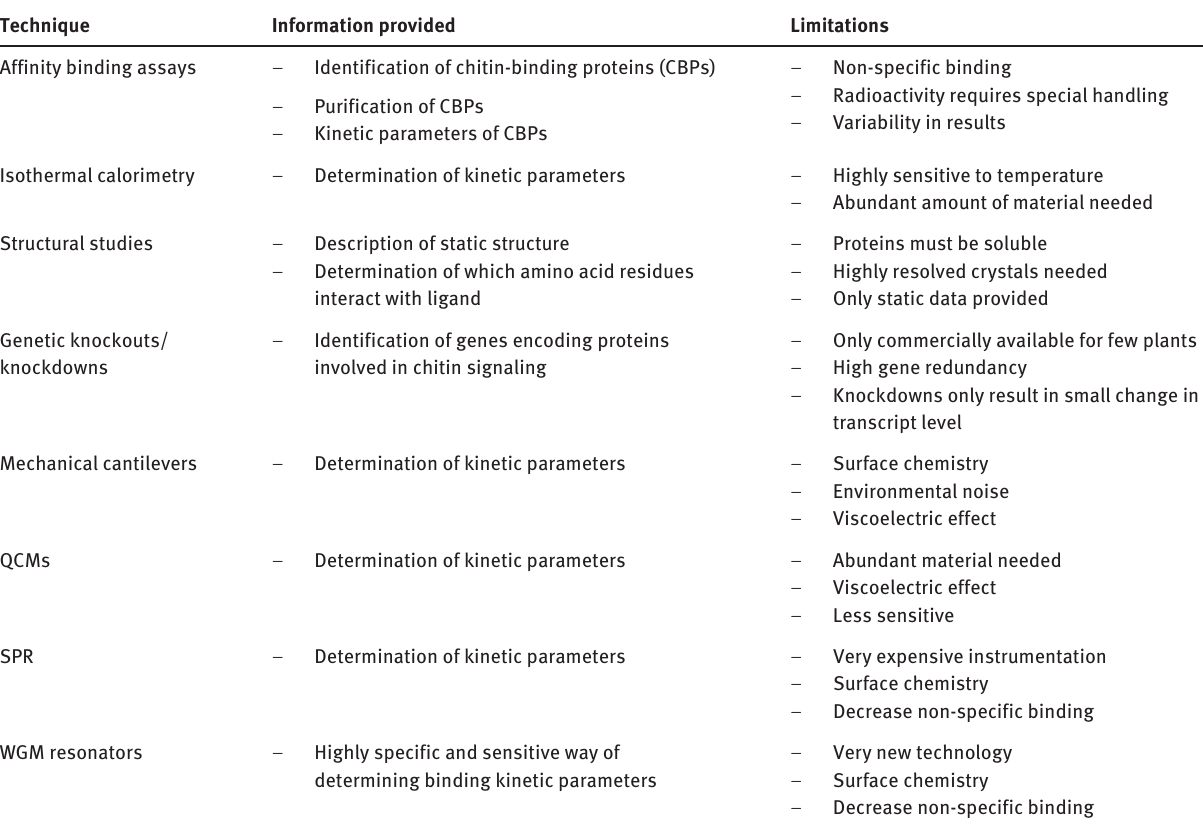
Table 1 Common techniques for analyzing biomolecular interactions.